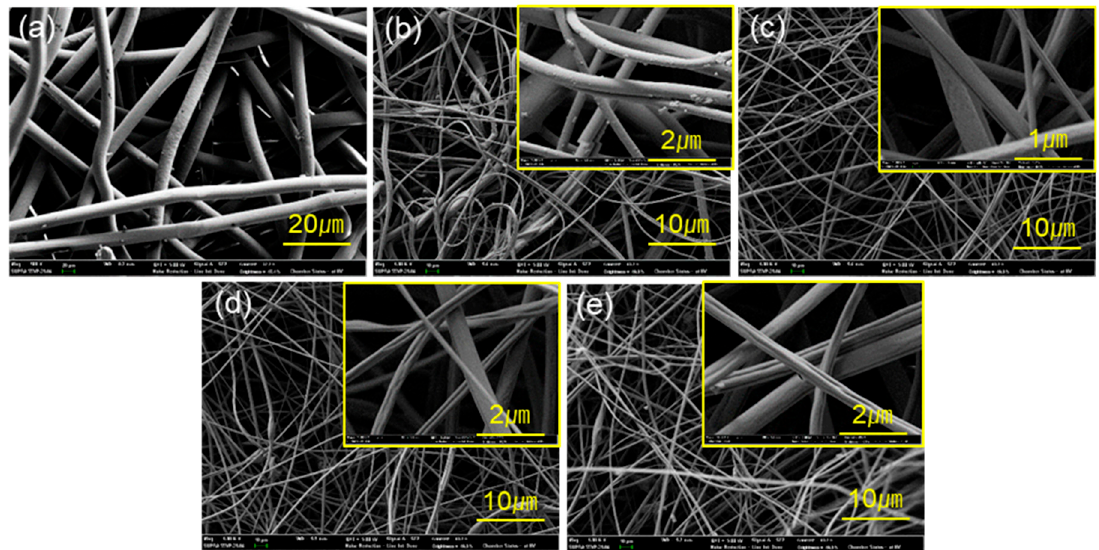
Figure 3. Scanning electron microscope (SEM) images of different webs. ( a ) polypropylene (PP) spunbound (SB); ( b ) PP meltblown (MB); ( c ) polystyrene (PS) electrospun web (ES); ( d ) PS(F) ES; ( e ) PS(O) ES (O 2 plasma-treated web). Table 1. X-ray photoelectron spectrometer (XPS) atomic concentration (%) of surfaces. Surface